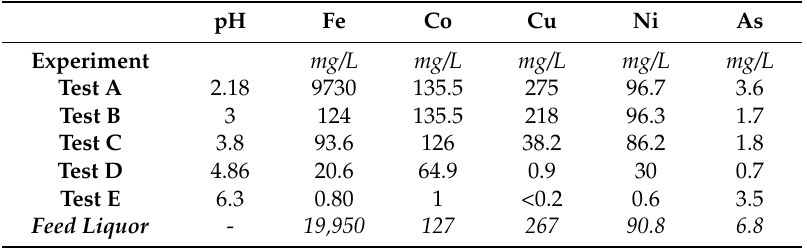
Table 3. Chemical assay and end pH values measured in sighter test final